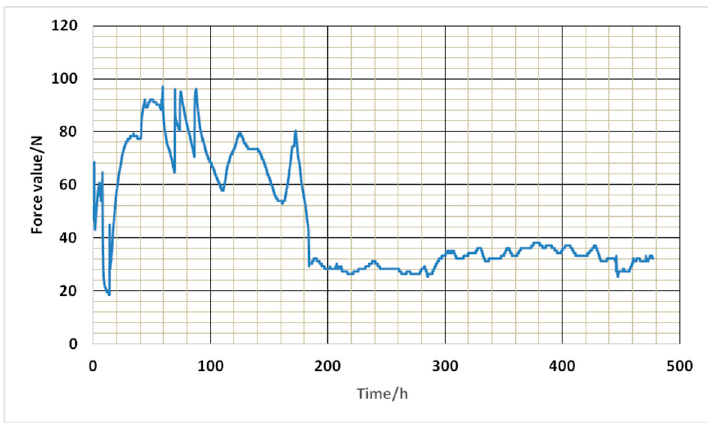
Figure 13. Test process of the specimen with voids a content of 3.0%.